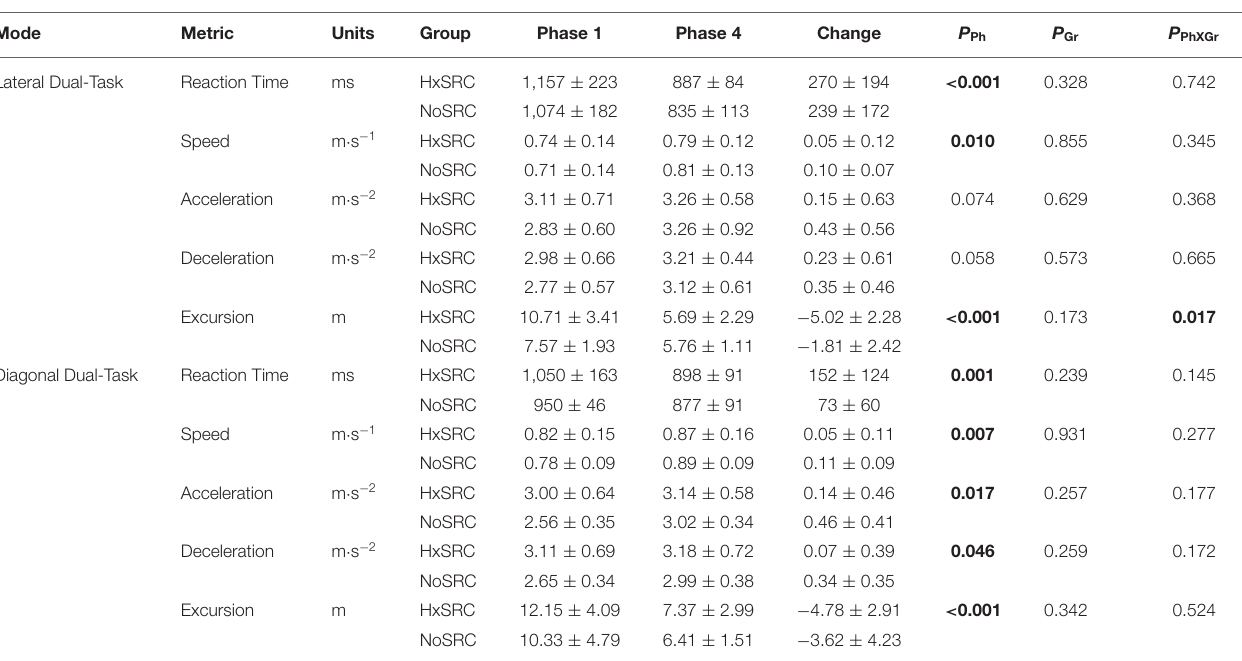
TABLE 5 | Group mean ± standard deviation for Dual-Task